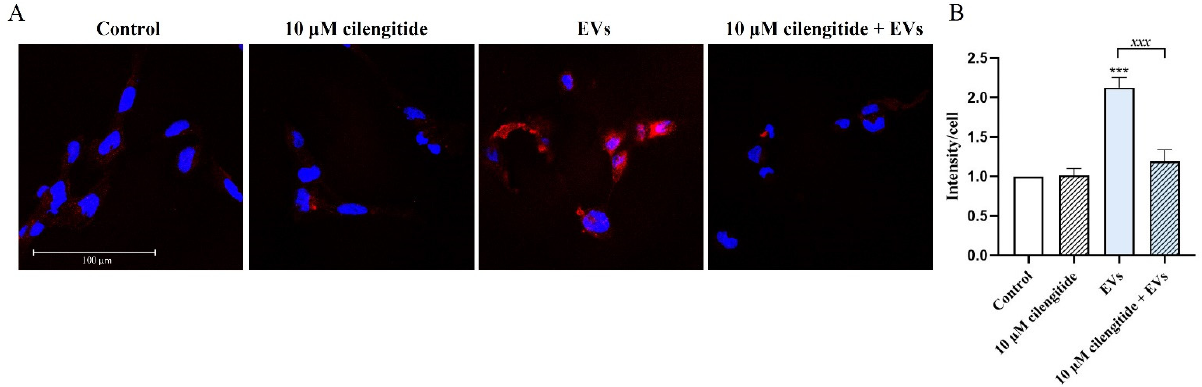
Figure 8. Inhibition of MFG-E8 receptor with cilengitide suppressed EV-induced formation of lipid rafts. ( A ) Confocal images of lipid rafts (red) expressing human microglial cells. The cells were pre-treated with 10 μ M cilengitide for 2 h and then treated with EVs (1 AU) of EVs for 30 min before lipid raft labeling and fixation. Lipid rafts were labeled with Vybrant ® Alexa Fluor ® 594 Lipid Raft Labeling Kit (Thermo Fisher Scientific) according to the manufacturer’s protocol. Nuclei, DAPI (blue). Scale bar = 100 μ m. ( B ) The mean fluorescence intensity of lipid rafts per cell were measured with Leica Application Suite X (LAS X) software. Data shown represent the results of 15 fields of view for each experimental group from three independent biological experiments ( n = 3), plotted as the mean ± SEM. Statistical significance was analyzed by Kruskal–Wallis test using Dunn’s multiple comparison post-hoc test, *** p < 0.001; xxx p < 0.001.